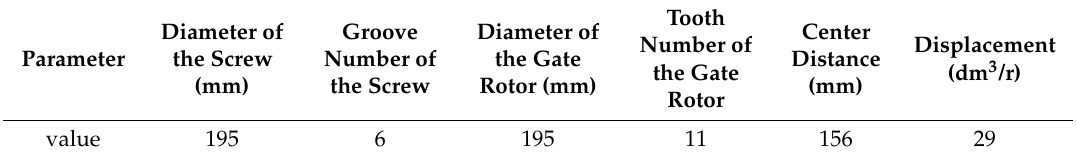
Figure 3. Photo of the single-screw expander prototype. Table 1. Parameters of the prototype.